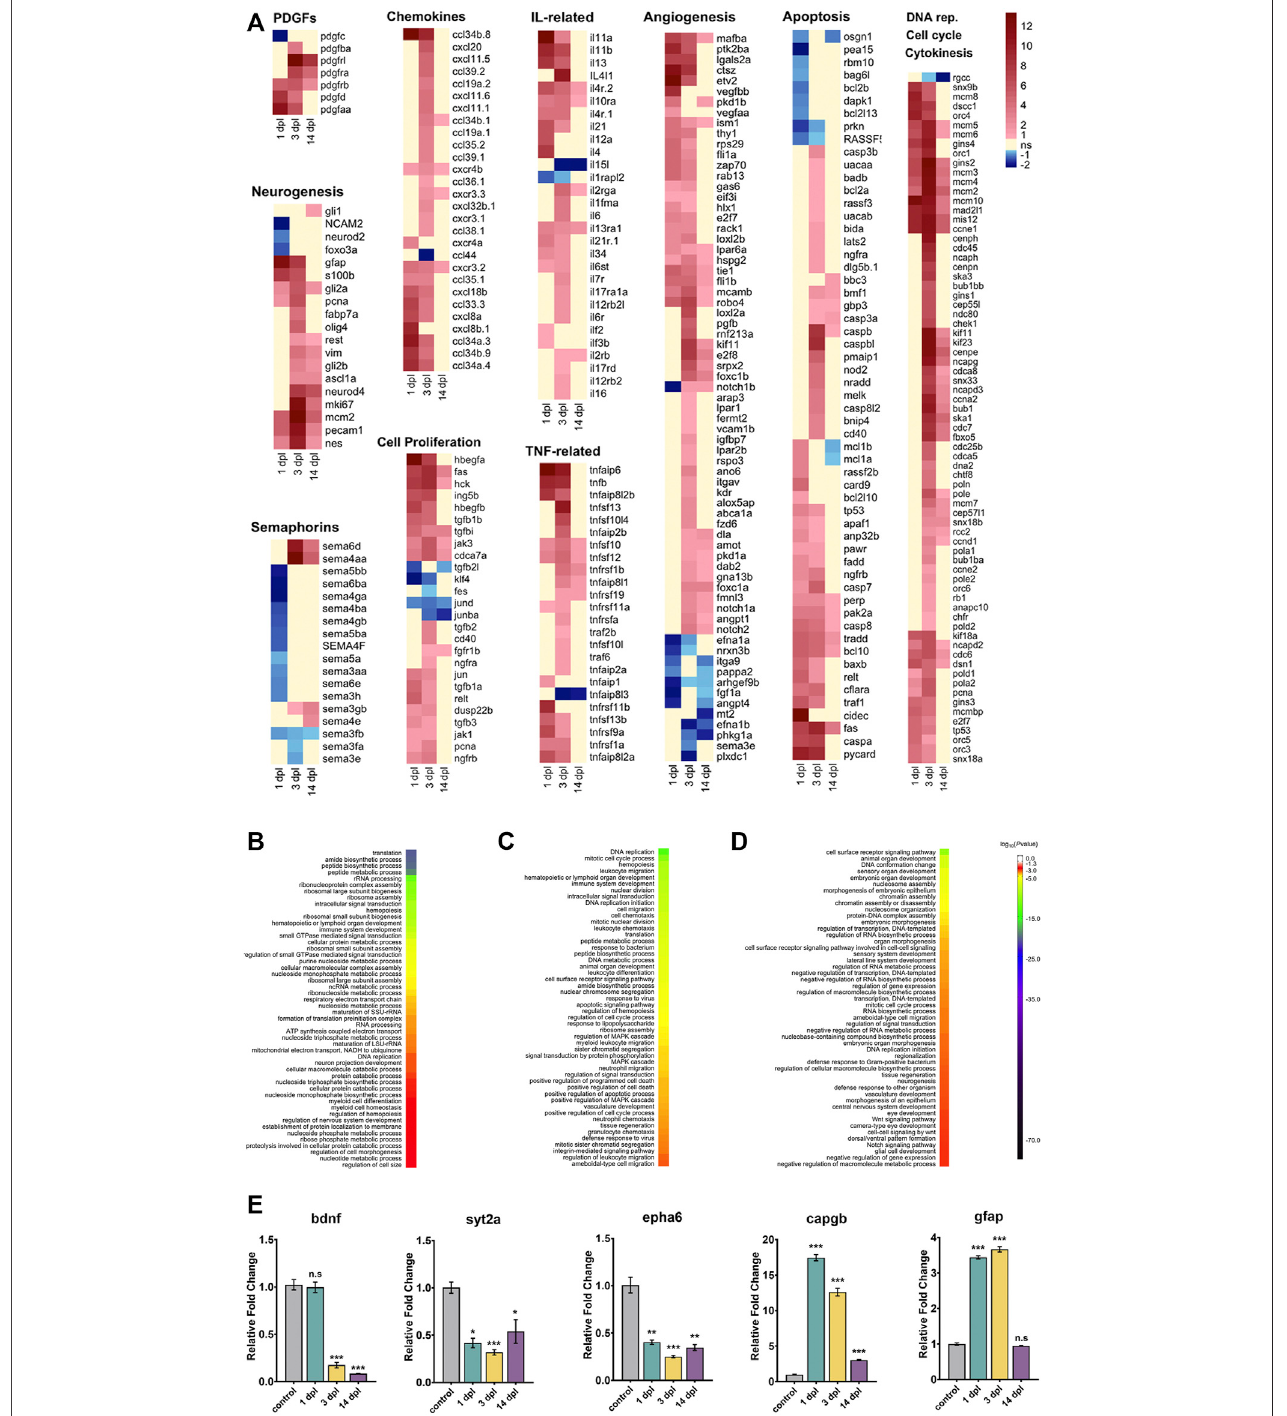
FIGURE2| Transcriptomepro fi lingandfunctionalannotationofthetelencephalonduringearlywoundhealing(1dpl),earlyproliferative(3dpl)anddifferentiation(14 dpl) stages of zebra fi sh brain regeneration. (A) Heatmaps of log 2 fold changes of selected genes across three stages of brain regeneration. Each column represents a time point and each row shows a single gene. The scale bar shows red for Up, blue for Down, yellow for weak regulation (FC < 1.5 in either direction) or statistically non- signi fi cant (Benjamini – Hochberg adjusted p -value (FDR) > 0.1). (B – D) GO-BP terms enriched at 1 dpl (B) , 3 dpl (C) and 14 dpl (D) by using all DEGs. DAVID was